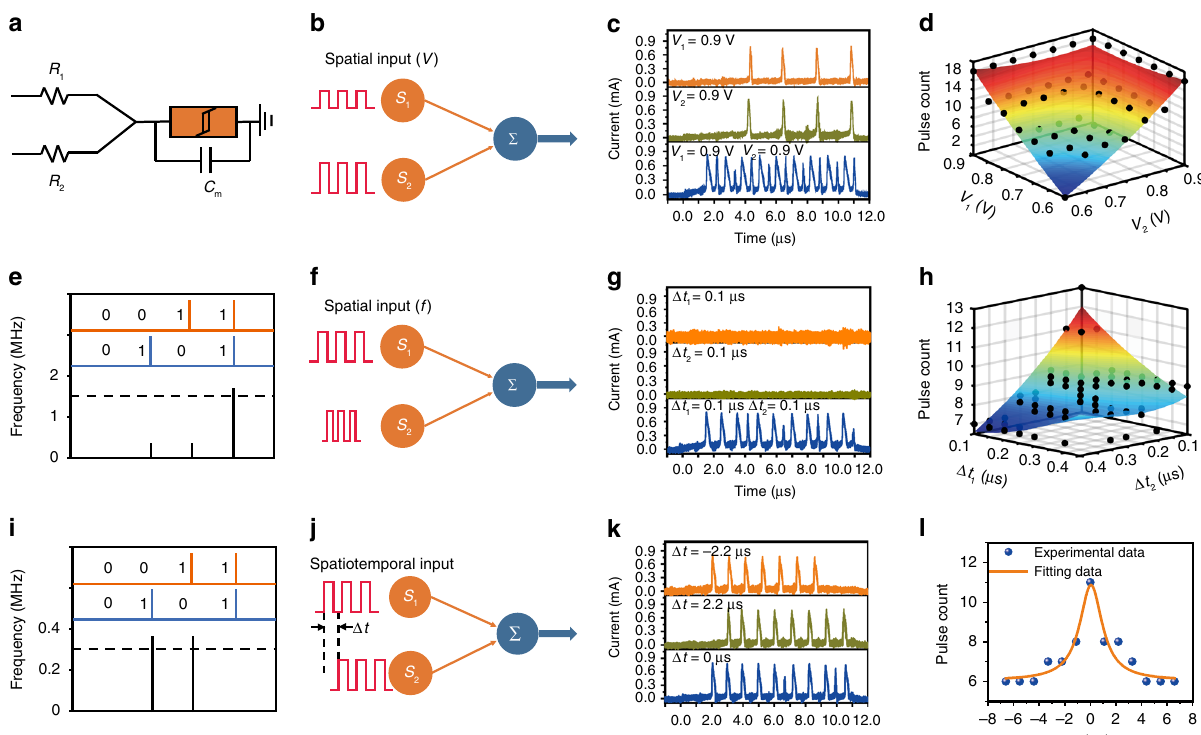
Fig. 3 Spatiotemporal integration and dynamic logic in NbO x based neuron. a The circuit diagram of the spiking neuron. b Schematic diagram of spatial summation with different input pulse amplitudes. c Neuronal response triggered by two input pulses (0.9 V amplitude, 1 μ s width, interval 0.1 μ s, 10 pulse cycles) applied on S 1 and S 2 individually and simultaneously. d The spatial summation at varied conditions and corresponding fi tting results. The amplitudes of the two input spikes ( V 1 and V 2 ) were systematically changed from 0.6 to 0.9 V, and applied simultaneously to the respective nodes. e The input – output characteristics for “ AND ” logic with two input pulses applied on S 1 and S 2 . f Schematic diagram of spatial summation with different input pulse intervals. g Neuronal response triggered by two input pulses (0.8 V amplitude, 1 μ s width, interval 0.1 μ s, 10 pulse cycles) applied on S 1 and S 2 individually